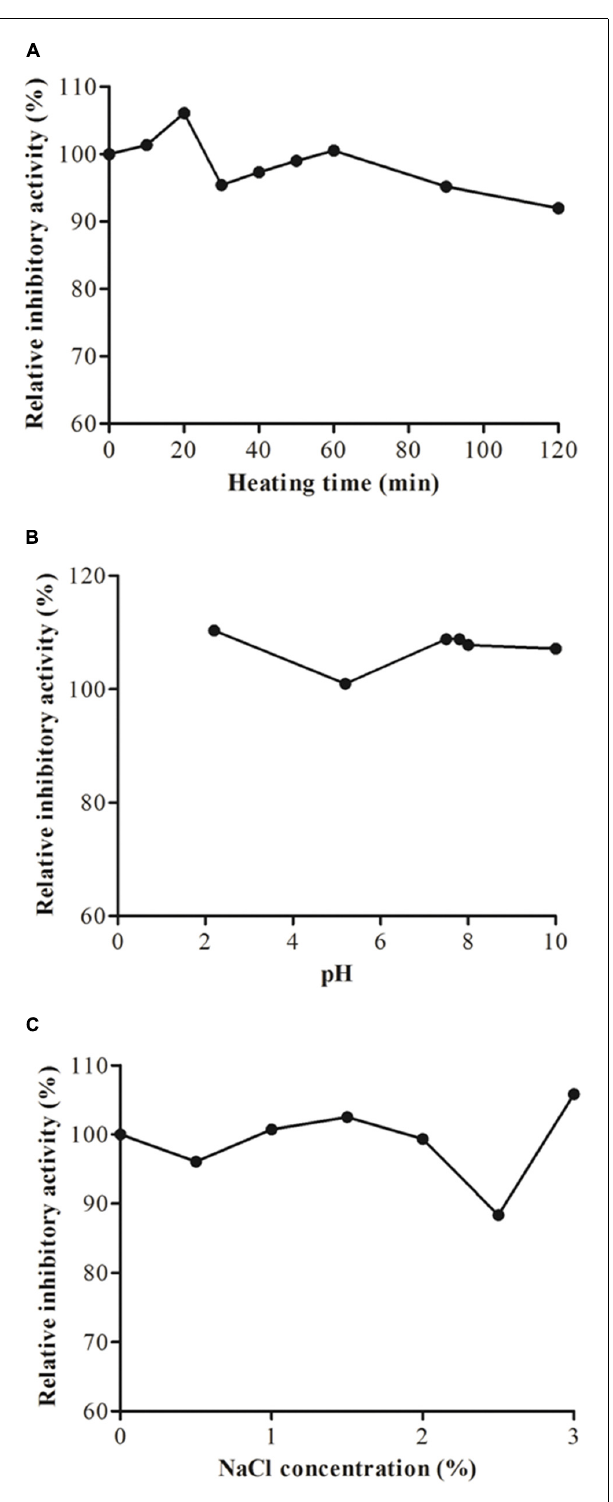
FIGURE 3 |Trypsin inhibitory activity assay of JcTI-I at pH 7.5, at room temperature (around 25 ◦ C) after: (A) heat-treatment; (B) incubation at pH 2–10 for 30 min; (C) incubation with 0–3 M NaCl concentration. Each point represents the mean of three estimates.The standard deviation was less than 10%.